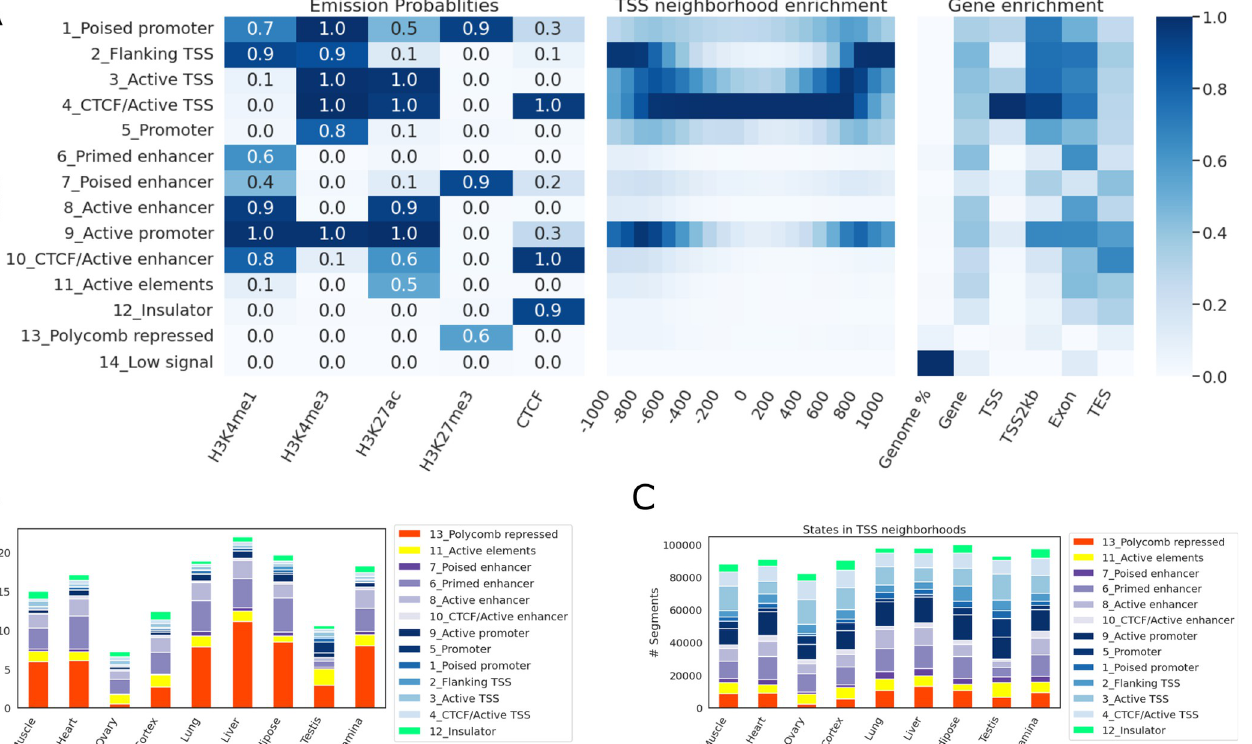
PLOS Genetics | https://doi.org/10.1371/journal.pgen.1010468 March 2,